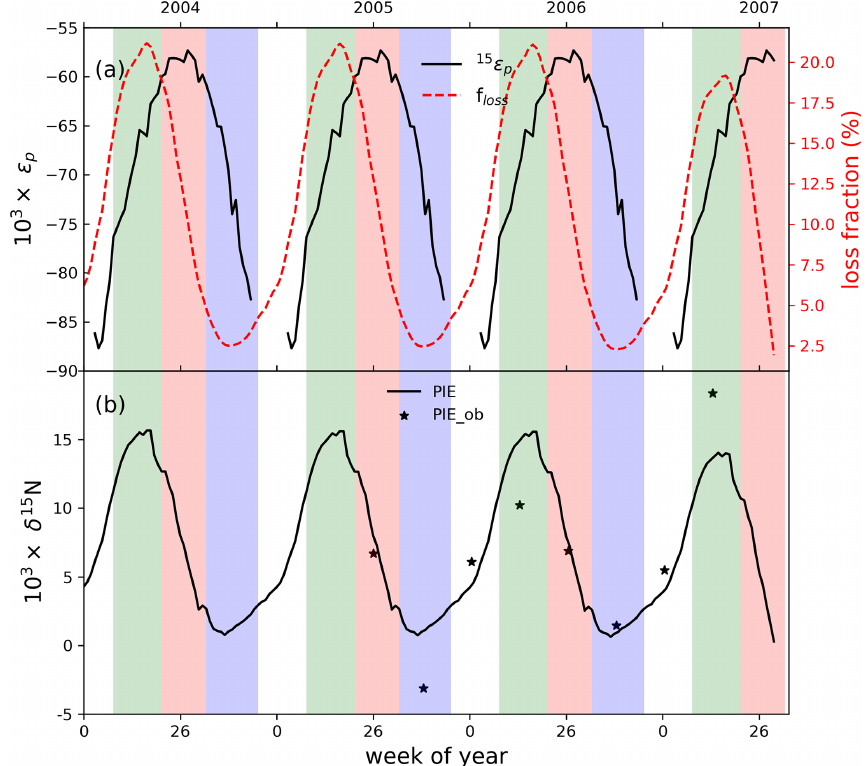
Figure 3. (a) The fraction of nitrate loss after deposition and the photolysis fractionation factor ( ε p ) at different weeks. (b) PIE: the photo- induced isotope effect. The solid star represents the estimated PIE from surface and snowpack nitrate data reported by Jarvis et al. (2009). The green, red, blue and white background colors represent spring, summer, autumn and winter,